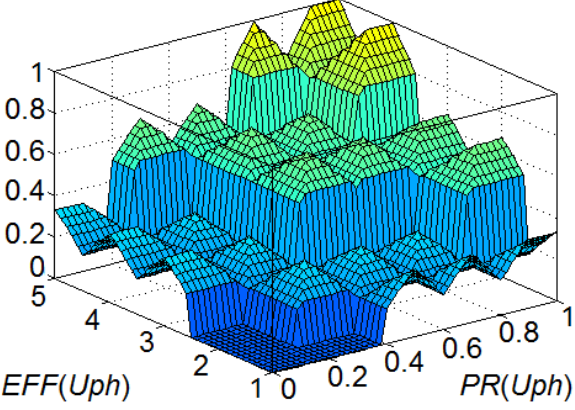
Figure 13: Surface solutions – smallest of maxima method